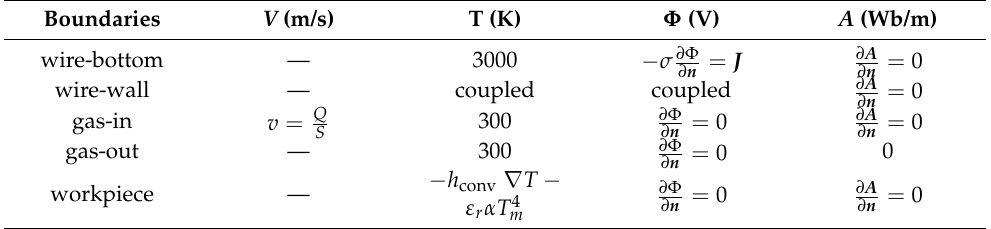
Table 2. Boundary